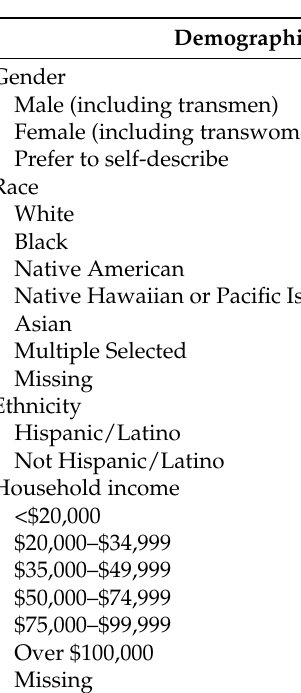
Table 2. Participants’ demographic characteristics ( n =